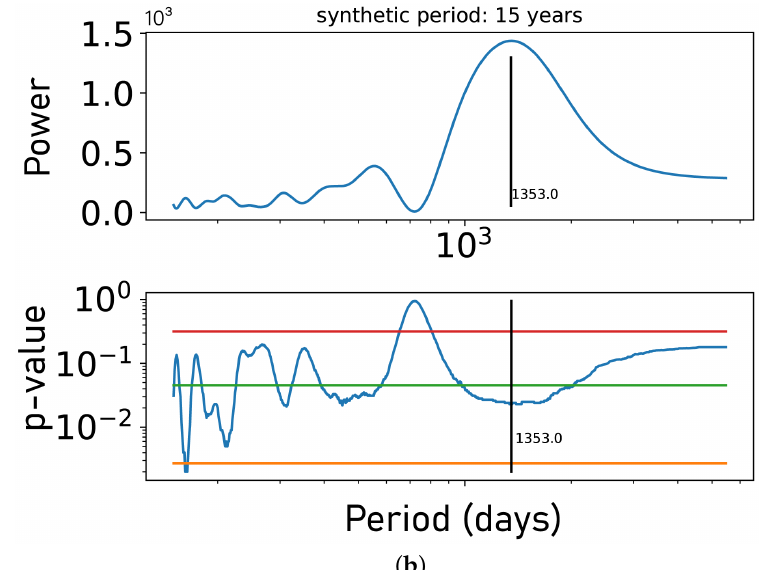
Figure 13. Two examples of the tests are shown in Figure 12. Panel ( a ) is from a single test and panel ( b ) from another. Both tests have a 15 years synthetic period, and an ∼ 4 years segment is used for analysis because the Kepler observation lasts about 4 years. Both tests find a signal at about 1300 days, but the second test does not pass our p -value criteria ( p -value < 3-sigma). The vertical line and corresponding label give the position of the strongest signal; the red, green, and orange horizontal lines show the 1-sigma, 2-sigma, and 3-sigma uncertainties,